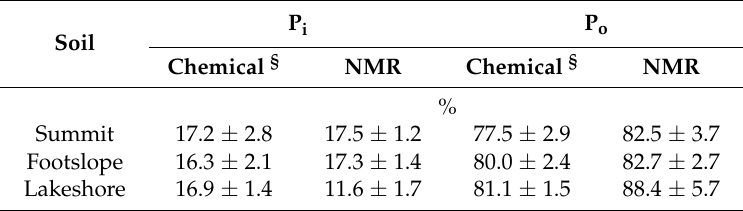
Table 3. Relative proportions of total P extracted for inorganic (P i ) and organic (P o ) forms in NaOH-EDTA extracts from humic soil samples (O horizon) determined by chemical extraction and 31 P-NMR spectroscopy.